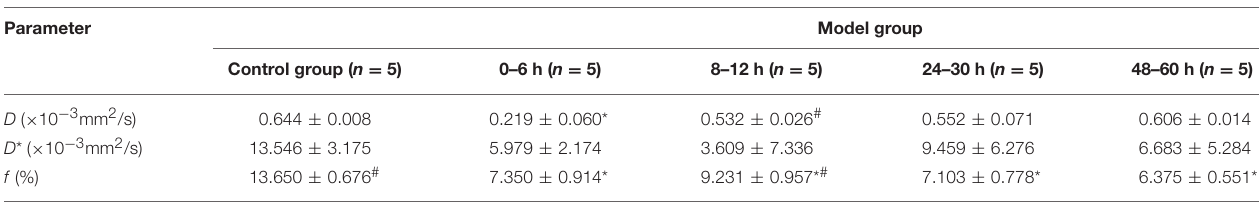
TABLE 1 | D , D *, and f parameters measured in newborn piglets from all groups.